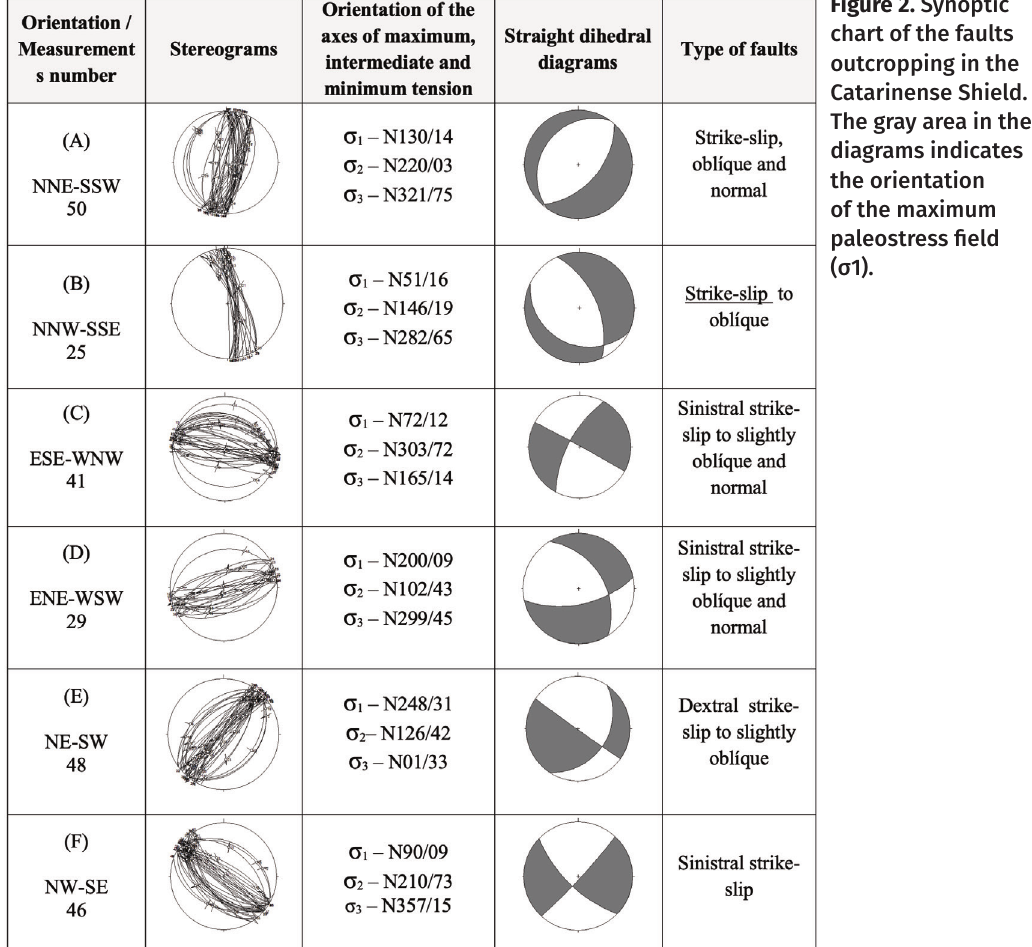
Figure 2. Synoptic chart of the faults outcropping in the Catarinense Shield. The gray area in the diagrams indicates the orientation of the maximum paleostress field